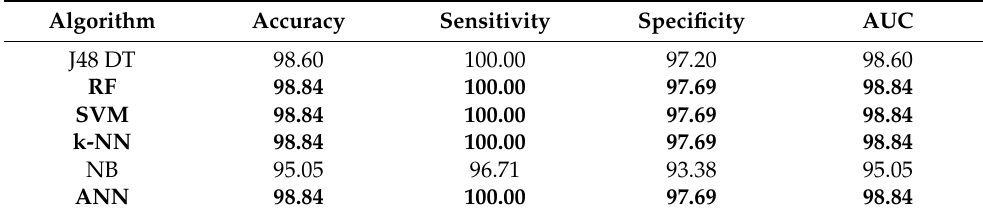
Table 12. Developed model’s performance evaluation result (training).